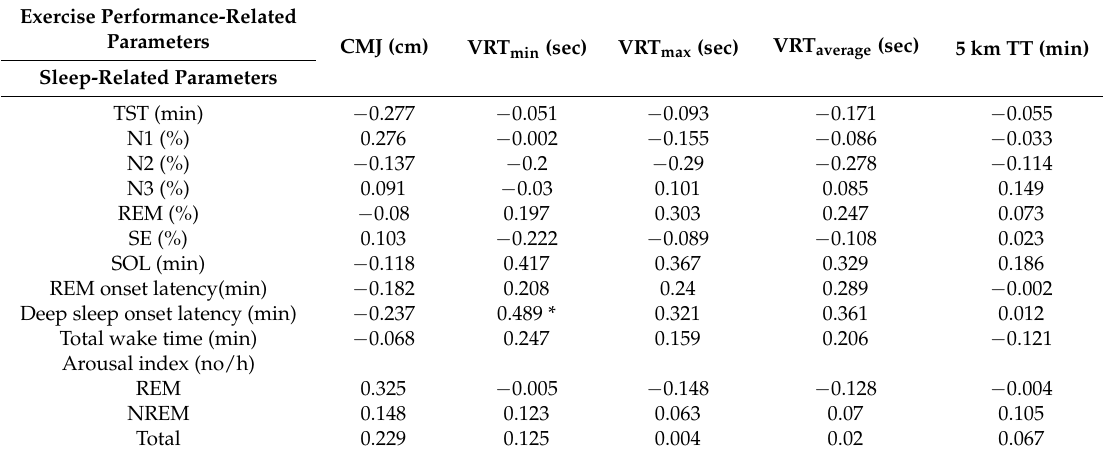
Table 3. Correlation coefficients between sleep-related and exercise performance-related parameters.